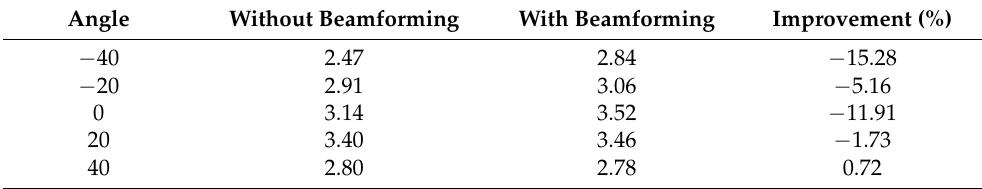
Table 5. The MAE of HR at 0.9 m.